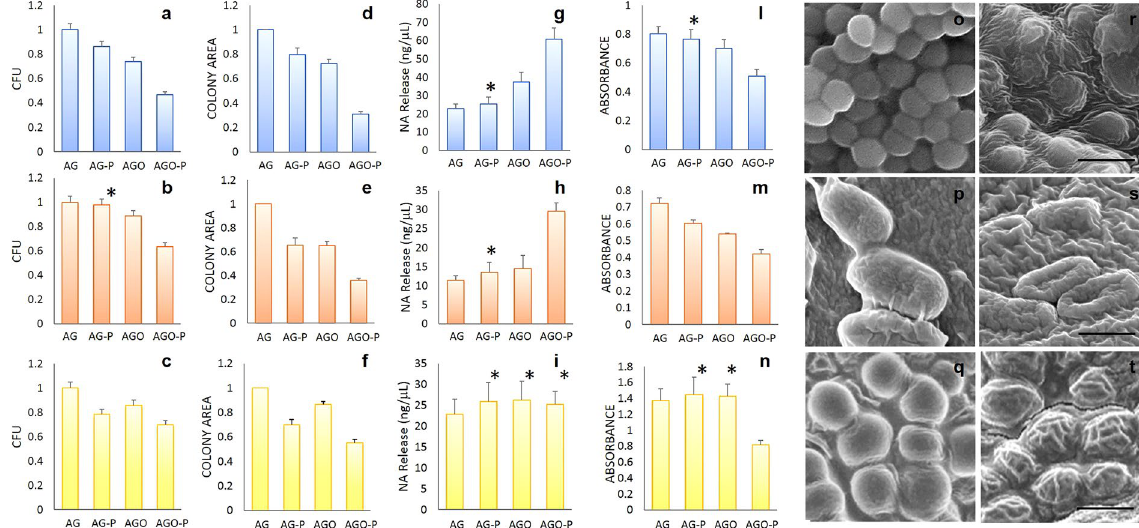
Figure 2. CFUs number, colony size, cell damage, metabolic activity and structural integrity of microorganisms grown on different substrates. Number of CFUs on different hydrogels: S. Aureus ( a ), E. Coli ( b ) and C. Albicans ( c ). Normalized colony diameter on different hydrogels: S. Aureus ( d ), E. Coli ( e ) and C. Albicans ( f ). Nucleic acid released after exposure to different hydrogels of S. Aureus ( g ), E. Coli ( h ) and C.Albicans cells ( i ). Metabolic activity quantification using XTT test for S.Aureus ( l ), E. Coli ( m ) and C.Albicans cells ( n ). Representative Scanning Electron Microscopy images of for S.Aureus ( o ), E. Coli ( p ) and C.Albicans ( q ) on AGO hydrogels or AGO-P hydrogels ( r–t ). Scale bar is 1 μ m in ( r ) and ( s ) and 10 μ m in ( t ). Asterisks indicate statistically not significant differences compared to the untreated agar hydrogel